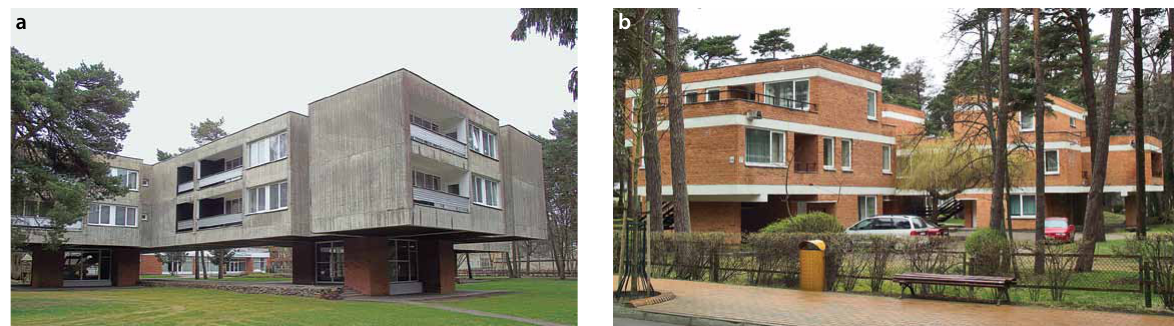
Fig. 4. Žilvinas hotel, Kęstučio g. 34, archit. a. lėckas, 1968 (a); The Žilvinėlis apartment building, Birutes al. 44,